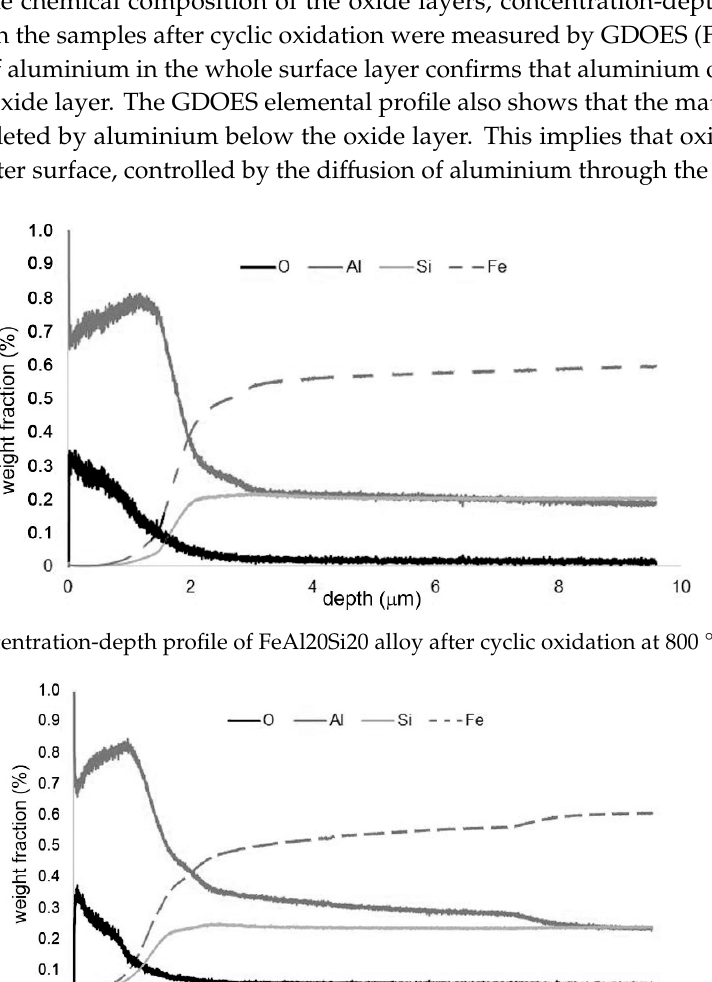
Figure 8. Dependence of the amount of delaminated oxide (g · m − 2 ) on duration of cyclic oxidation at 800 and 1000 °C in air for FeAl20Si20 alloy.